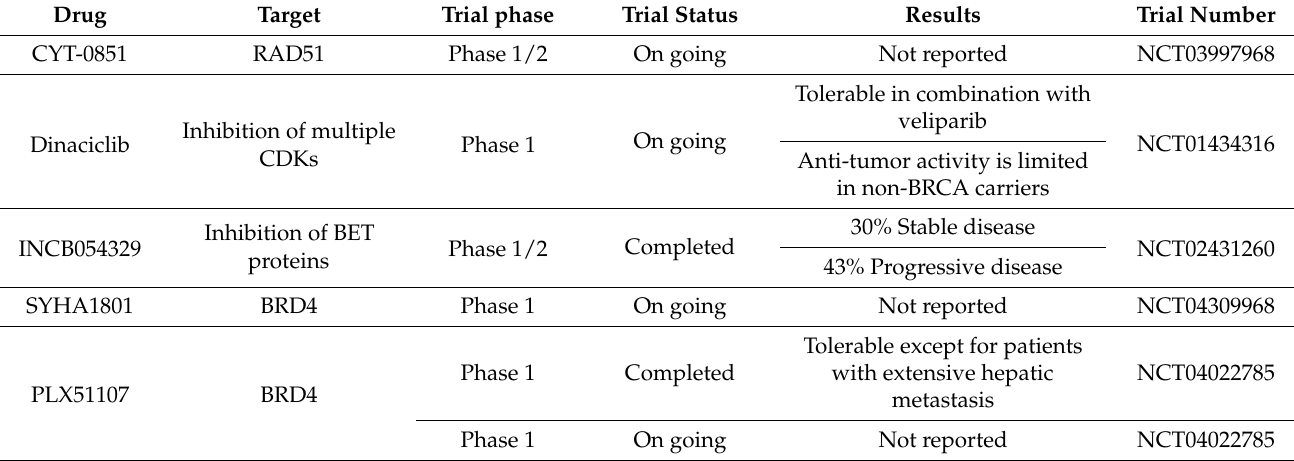
Table 2. Molecules targeting potential regulators of RAD51 expression and function tested in clinical trials.